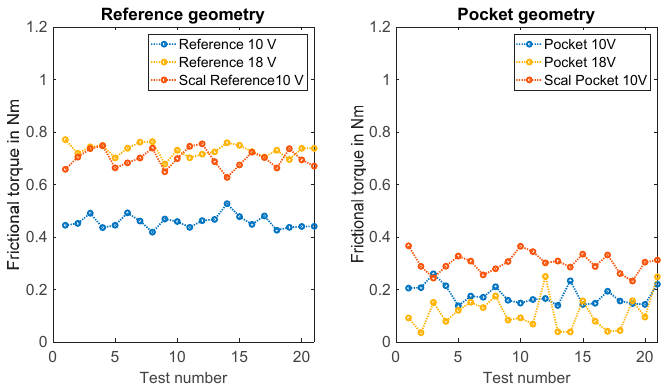
Figure 14. Frictional torque of the two geometry variants. The frictional torques at measuring shaft 2 are plotted above the test number.